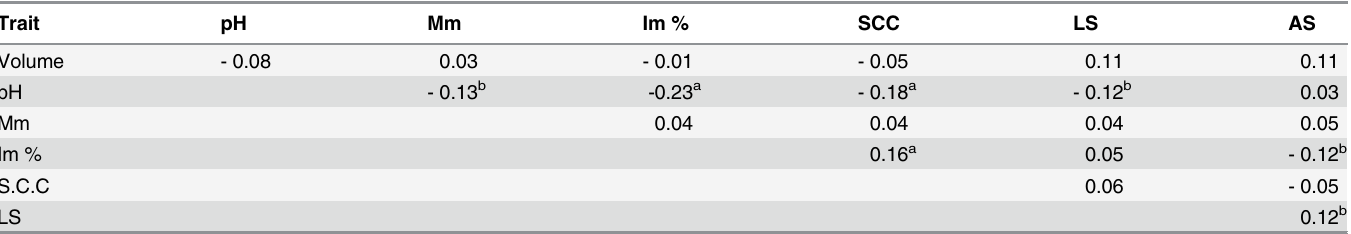
Phenotypic correlation among different semen quality parameters Individual motility (Im) had a significant (p < 0.01) positive correlation with SCC (r = 0.16; Table 2). Also, percentage of live sperm was positively correlated with the percentage of abnor- mal sperms (r = 0.12). On the contrary, Im had a significant (p < 0.05) negative correlation Table 2. Phenotypic correlations among semen quality parameters. Trait pH AS